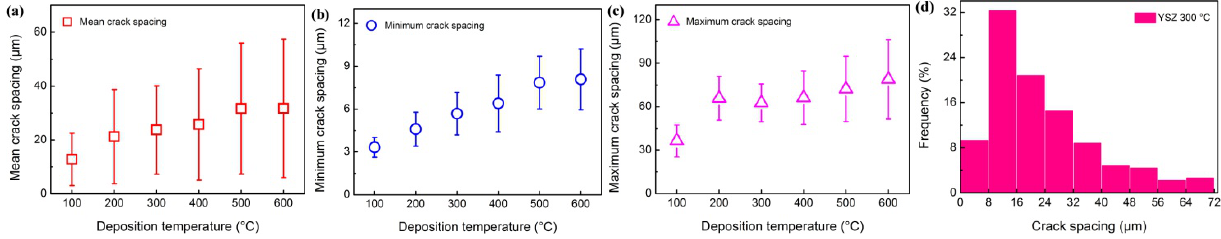
Fig. 6 Statistical (a) mean, (b) minimum, and (c) maximum crack spacing of 7YSZ splats at the deposition temperature of 100–600 ℃ . (d) Detailed distribution of crack spacing of 7YSZ splats at the deposition temperature of 300 ℃ . The crack spacing was distributed in a considerable range, which clearly implied delamination had already occurred during the splat